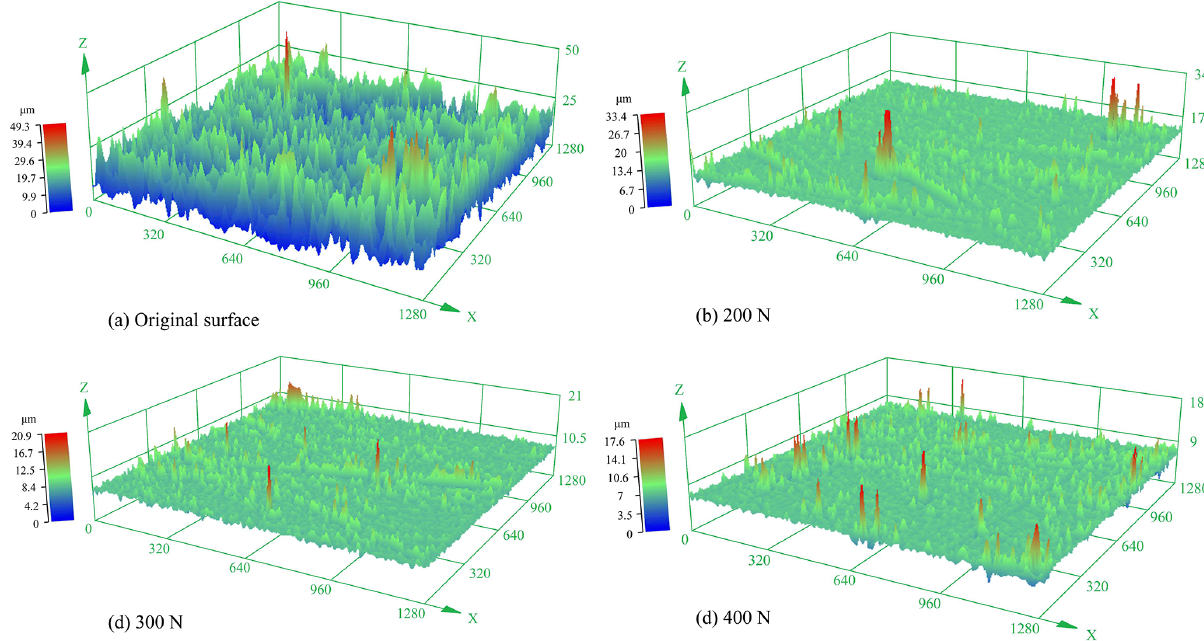
Figure 5. The 3D surface topography of the wear surface under dry friction.